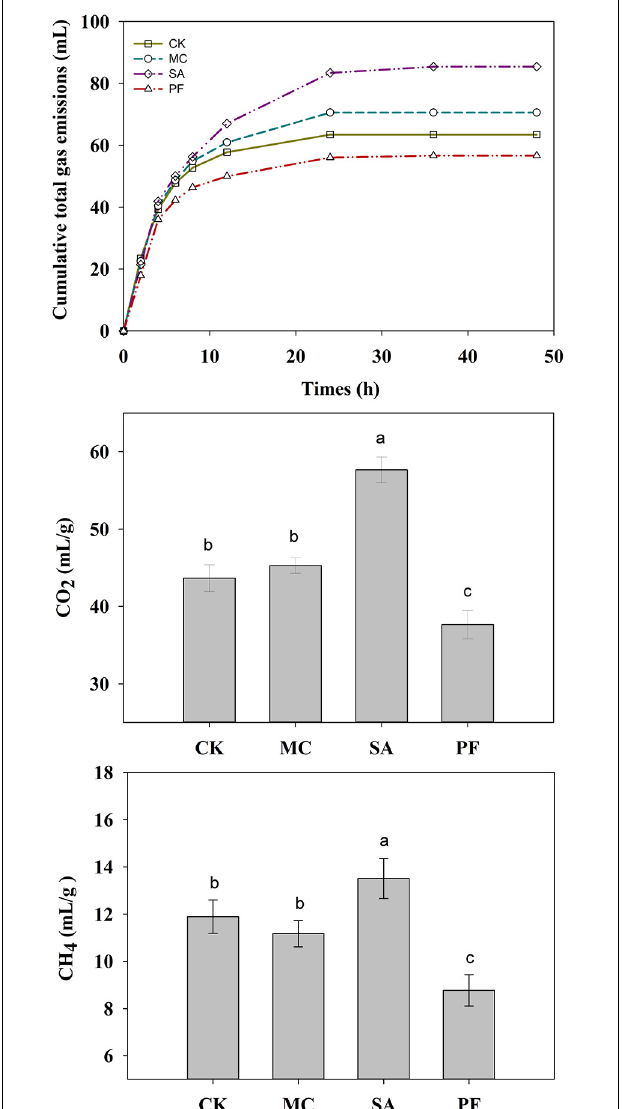
a − c Means of additives treatments within a row with different superscripts differ (P < 0.05). DM, dry matter; IVDMD, in vitro dry matter digestibility; IVNDFD, in vitro neutral detergent fiber digestibility; IVADFD, in vitro acid detergent fiber digestibility; CK, without additives; MC, 5% mint; SA, 5% clove; PF, 5% purple perilla; SEM, standard error of means.